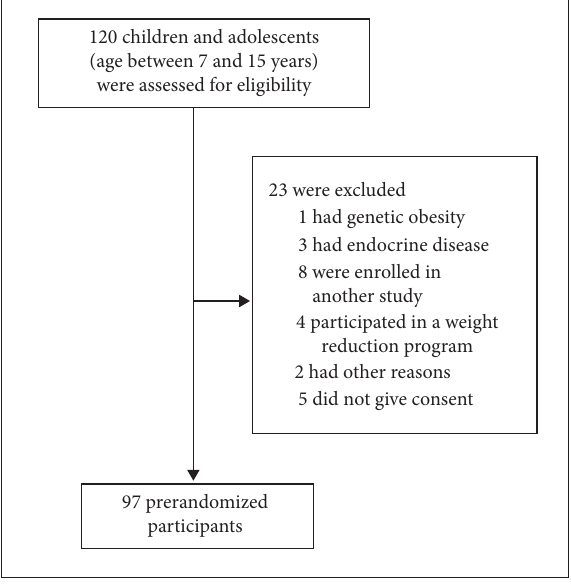
Figure 1: Recruitment flow chart. Table 1: Demographic data, body composition, dietary assessment, and CEBQ scores of the